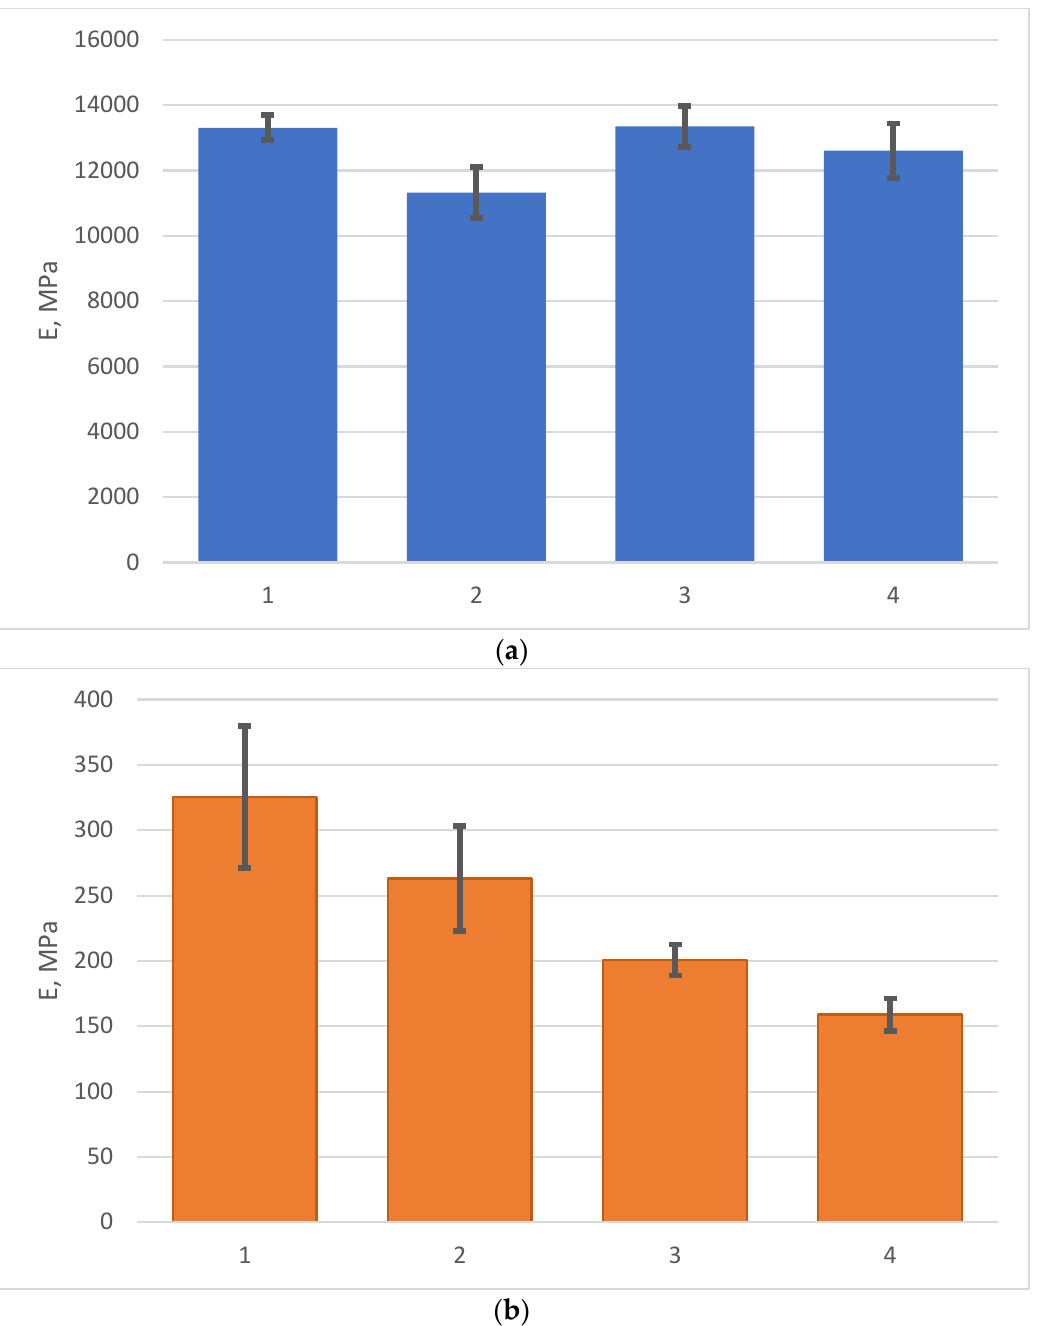
Figure 5. Mean values of elastic modulus ( a ) and bending strength ( b ) with standard deviations: (1) Epoxy FRP on EZ-200 unexposed; (2) Epoxy FRP on EZ-200 exposed; (3) Epoxy FRP on T-23 unexposed; (4) Epoxy FRP on T-23 exposed. Table 1. Results of bending strength and modulus of elasticity at room temperature of fiberglass plastics before and after curing.